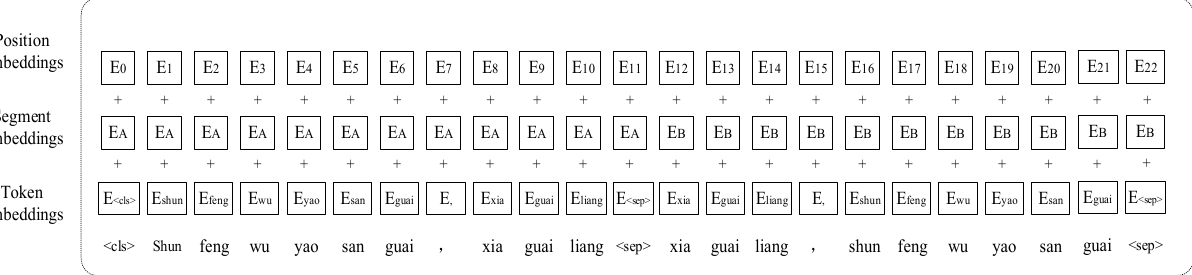
Figure 2. Input structure diagram of Ernie-Gram model.